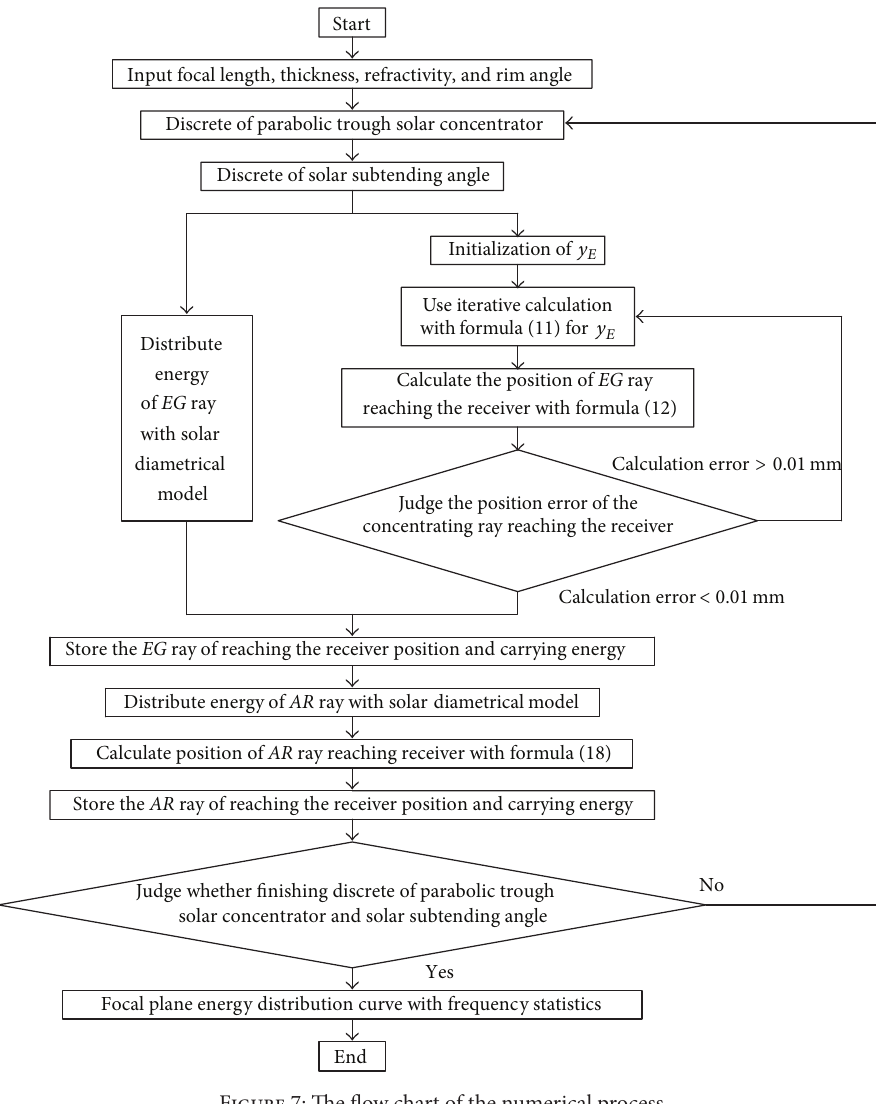
Figure 7: The flow chart of the numerical